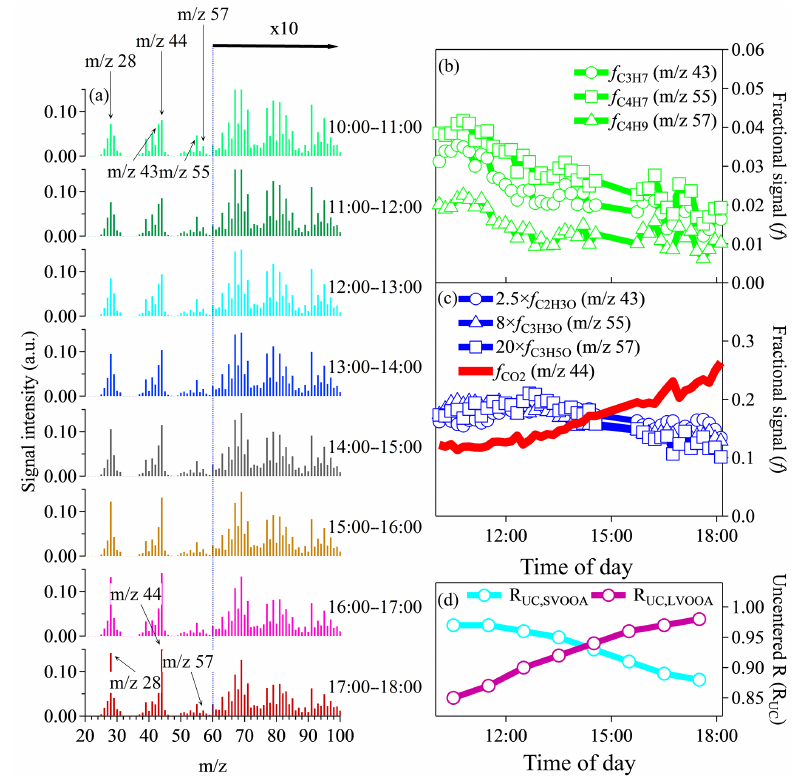
Figure 11. Evolution of high-resolution organic mass spectra from 10:00 to 18:00LT during the photochemical aging process in E4. (a) Mass spectral evolution; (b) changes in relative intensities of hydrocarbon-like ions: C 3 H + (c) changes in relative intensities of oxygen-containing ions: C 2 H 3 O + ( m/z 43), C 3 H 3 O + ( m/z 55), C 3 H 5 O + ( m/z 57) and CO + and (d) correlation of OA mass spectra with reference (Mohr et al., 2012) SVOOA and LVOOA mass